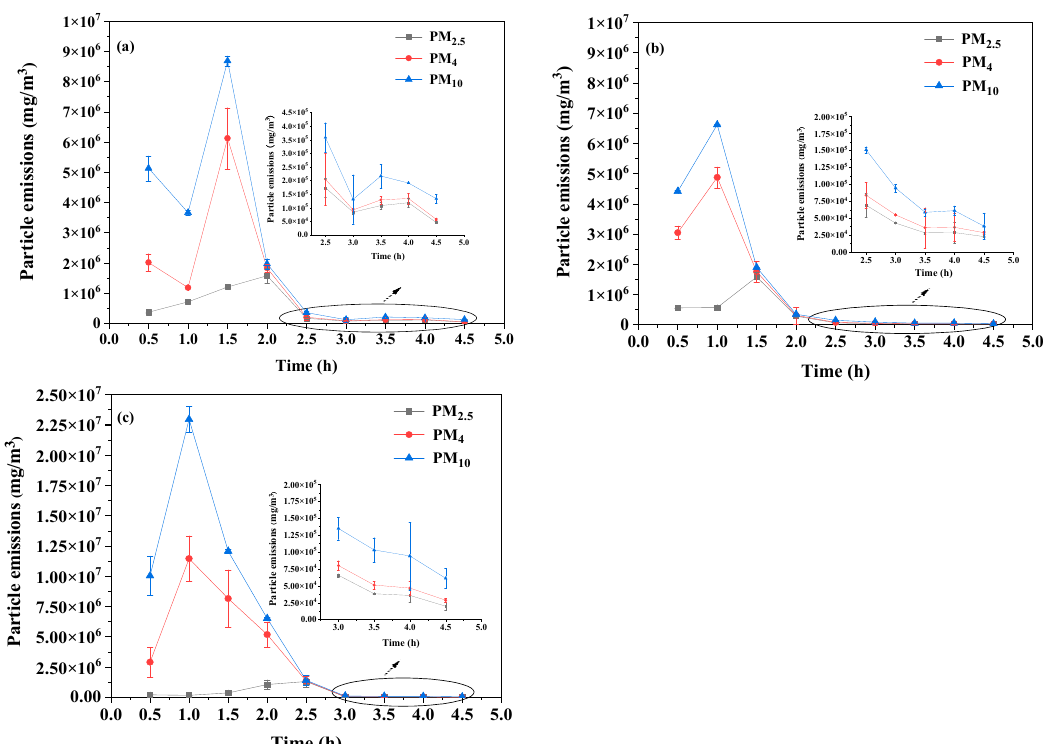
Figure 7. Particle emissions from the smouldering combustion: ( a ) particle emissions at 2% MC; ( b ) particle emissions at 12% MC; ( c ) particle emissions at 22% MC.